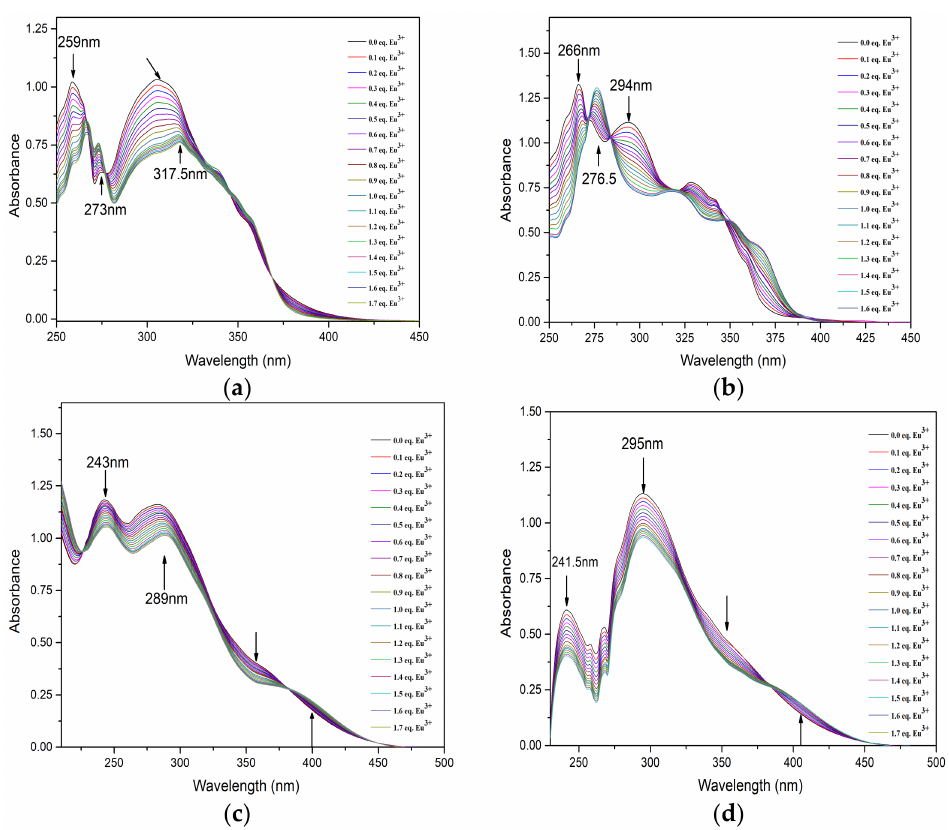
Figure 5. UV–visible absorption spectroscopic titrations of ligands (( a ) for L 1 , ( b ) for L 2 , ( c ) for L 3 , ( d ) for L 4 ) complexing with Eu 3+ in CH 3 OH solution (T = 298 ± 0.1 K, I = 0.01 M Et 4 NNO 3 , initial